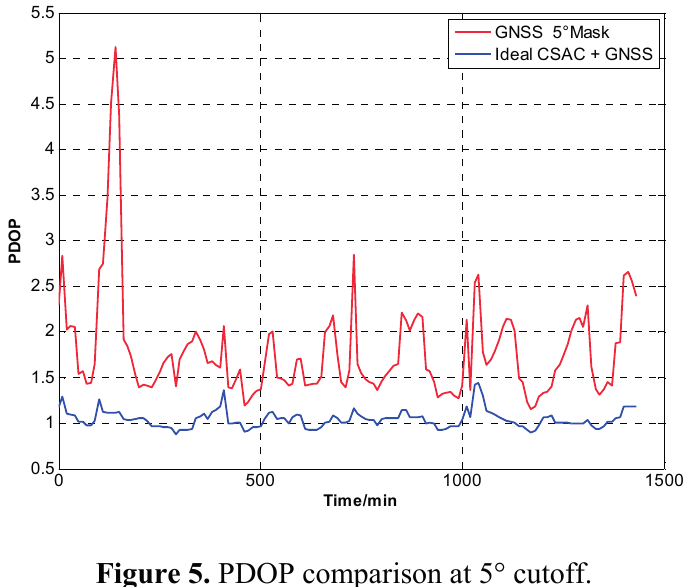
Figure 5. PDOP comparison at 5° cutoff.